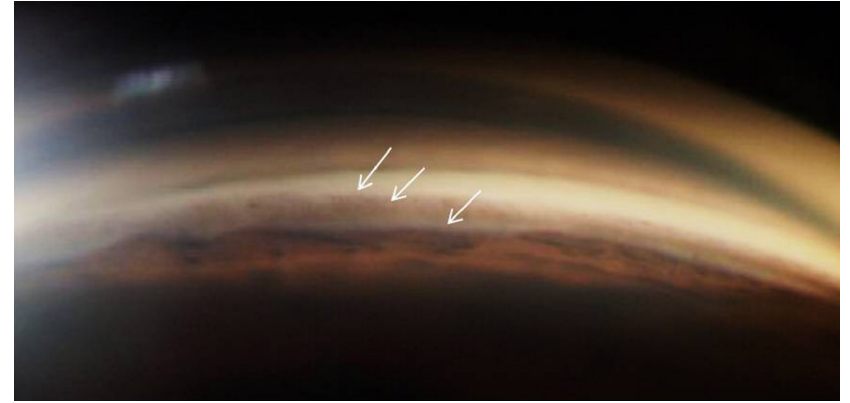
Figure 2: Gonioscopy after stopping mirtazapine shows open angles (Shaffer’s grade